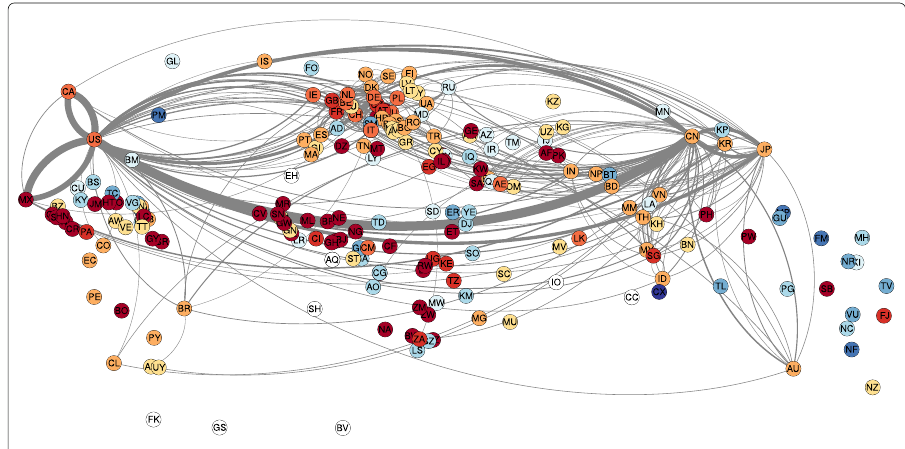
Fig. 1 2016 World trade network. Two countries A and B are related by a directed link, the direction of which is given by its curvature. If A points to B following the bent path in the clockwise direction (A (cid:3) B) then A exports to B, otherwise, i.e. (A (cid:4) B), B exports to A. The width of the link is proportional to the exportation volume in the WTN from the source country to the target country. The colors of country nodes range from red (blue) for a country going to bankruptcy at stage τ = 0 ( τ = τ ∞ ) in the case of a bankruptcy threshold κ = 0.1 and for the following crisis scenario: once a country goes to bankruptcy, it is prevented to import products with the exception of petroleum and gas (see details in the “Contagion model” section). Only transactions above 10 10 USD are shown. Most of the Polynesian islands have been removed, here and in